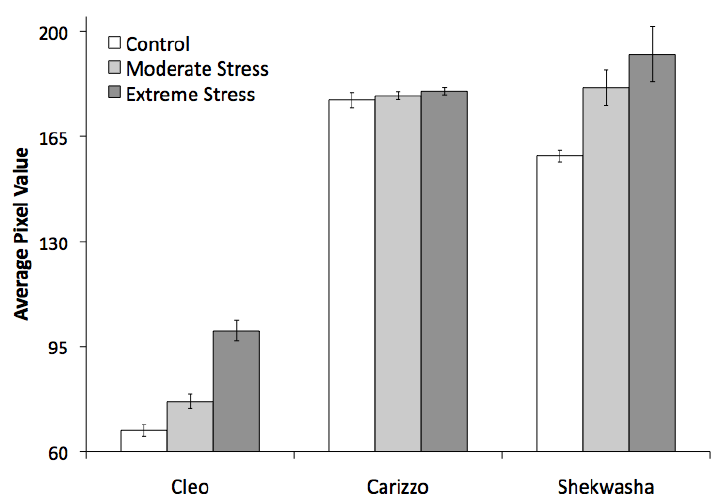
Figure 3. Average pixel value estimated with thermal image